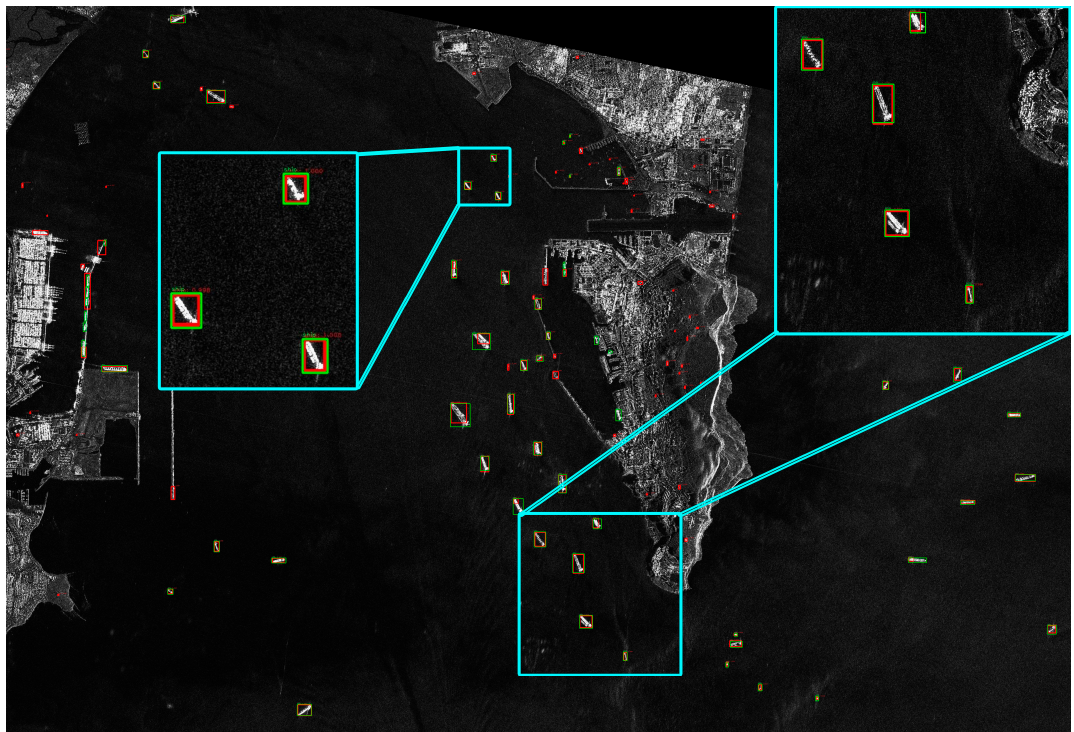
Figure 15. Ship detection results with the HR-SDNet on the real SAR image from the Strait of Gibraltar. (Red boxes denote predicted results; green boxes denote ground-truth).